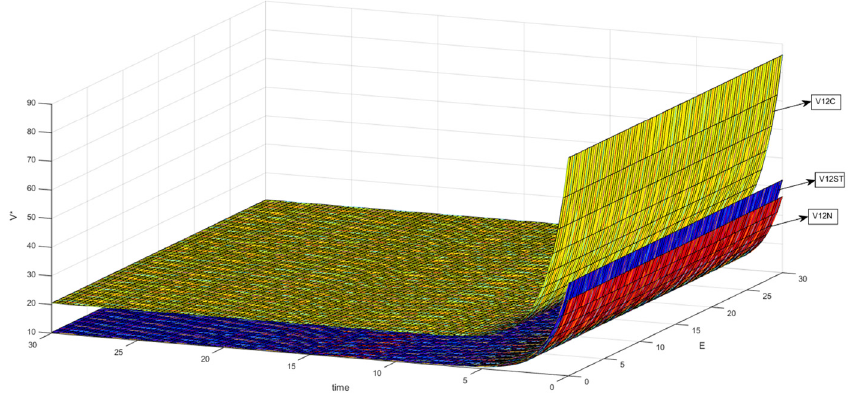
Figure 3: Comparison of total bene fi ts under three games in digital ecosystem.